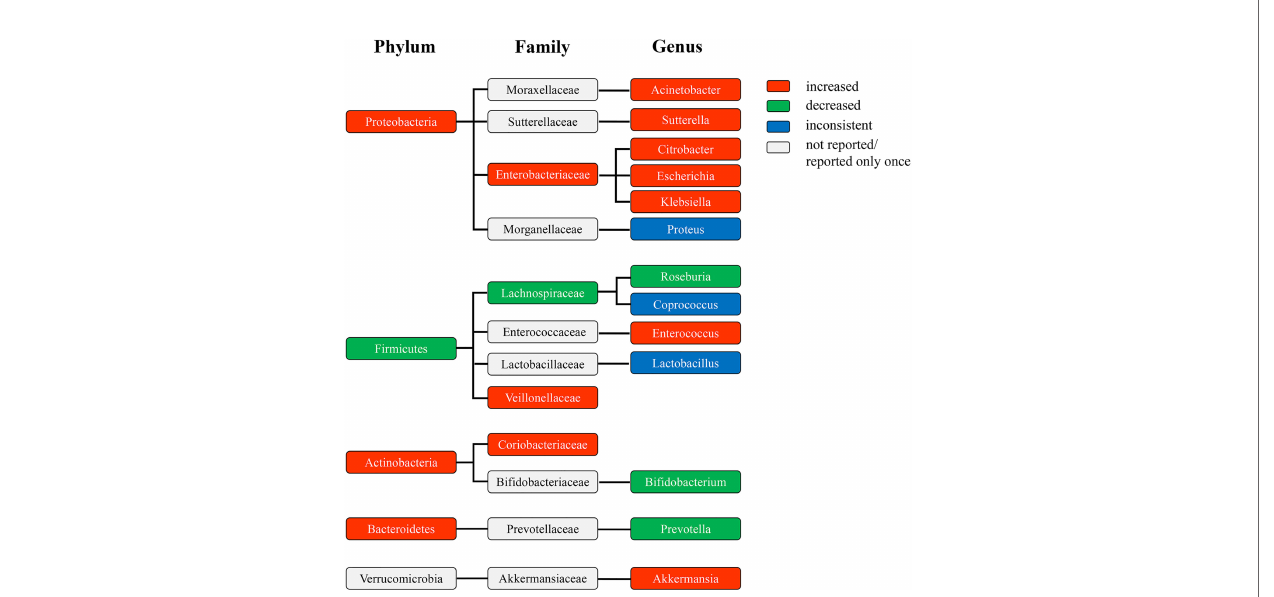
FIGURE 3 | The phylogenetic pro fi le of differentially abundant taxa at the phylum, family, and genus level of patients with DKD compared to HC. The colors indicate different bacterial variations at the phylum, family, and genus levels. Red, abundance increased. Green, abundance decreased. Blue, abundance inconsistent. Gray, abundance not reported or reported only once. DKD, diabetic kidney diseases; HC, healthy